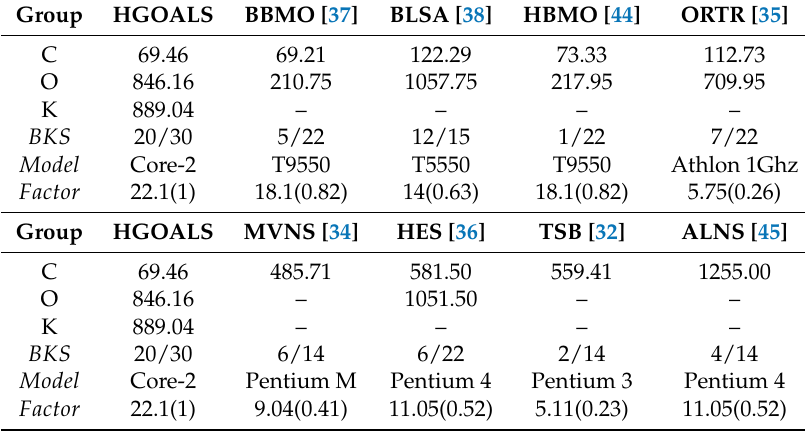
Table 10. Average CPU times comparison for the different solution approaches (hierarchical objective function).